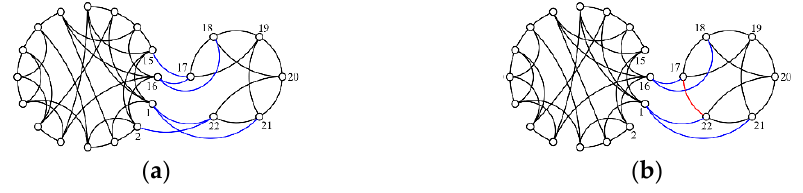
Figure 2. Schematic diagram of coupling network and correct reconnection. ( a ) The nearest-neighbor coupling network; ( b ) correct reconnection.